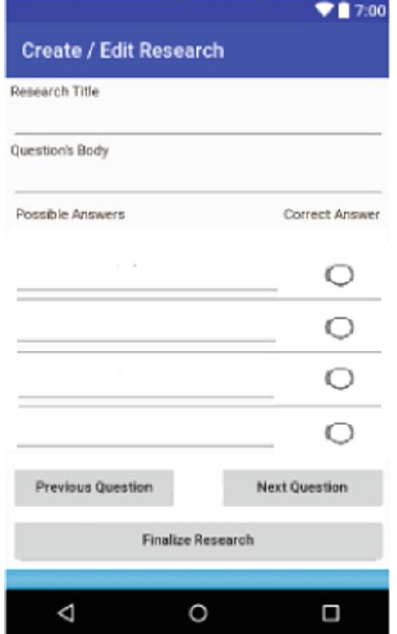
Figure 4. Create or edit research interface